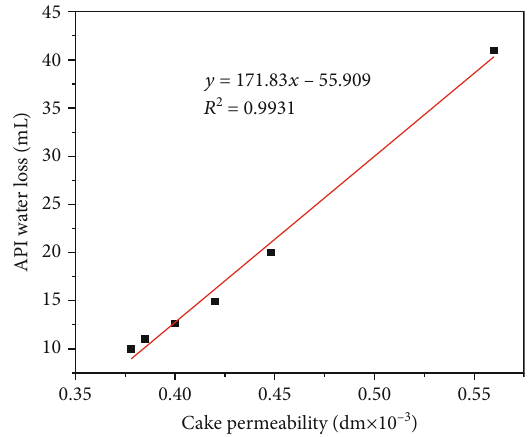
Figure 8: Relation between fi lter cake permeability and API fi ltration under di ff erent HTRTP